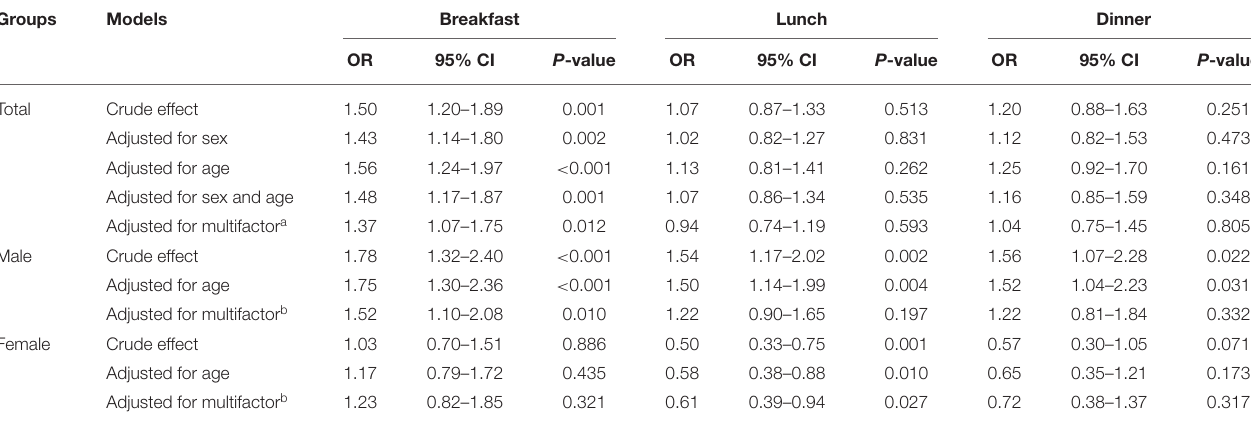
TABLE 3 | Association between eating away from home and risk of high serum uric acid regarding breakfast, lunch, and dinner. Groups